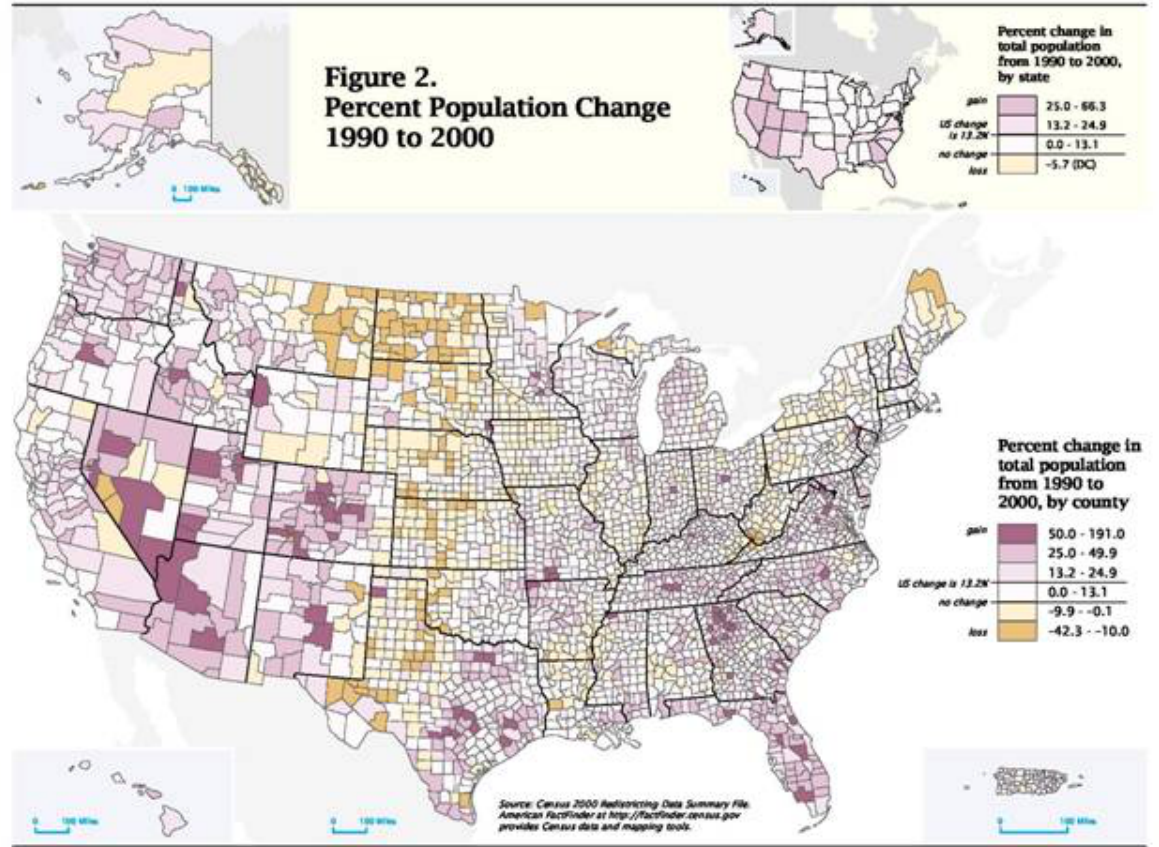
Figure 1. Percent change in population for U.S. States